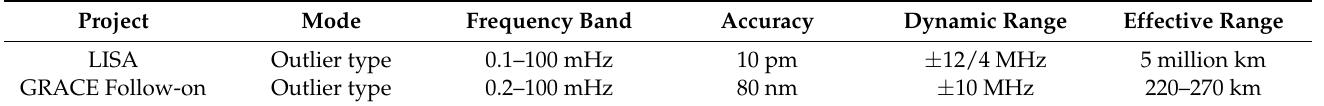
Table 8. LISA and GRACE Follow-on laser-ranging system performance.